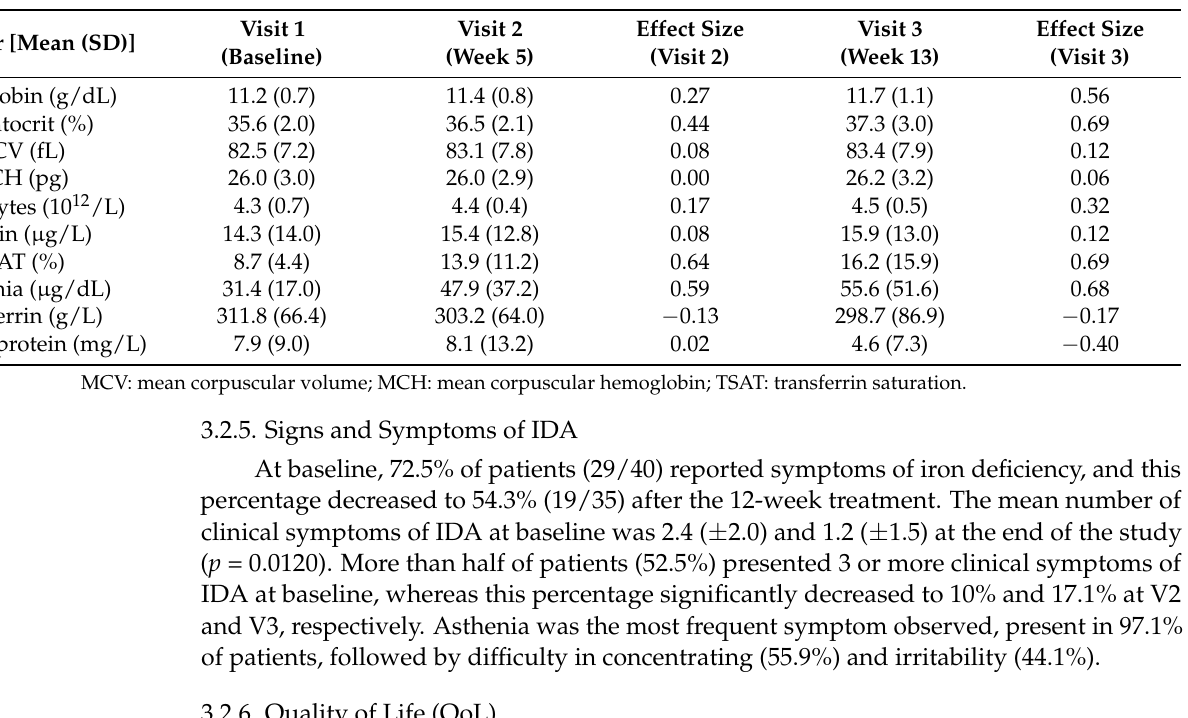
Table 4. Hematological and biochemical parameters before and after oral iron supplementation with Sucrosomial ® iron. Visit 1 Parameter [Mean (SD)] Hemoglobin (g/dL)